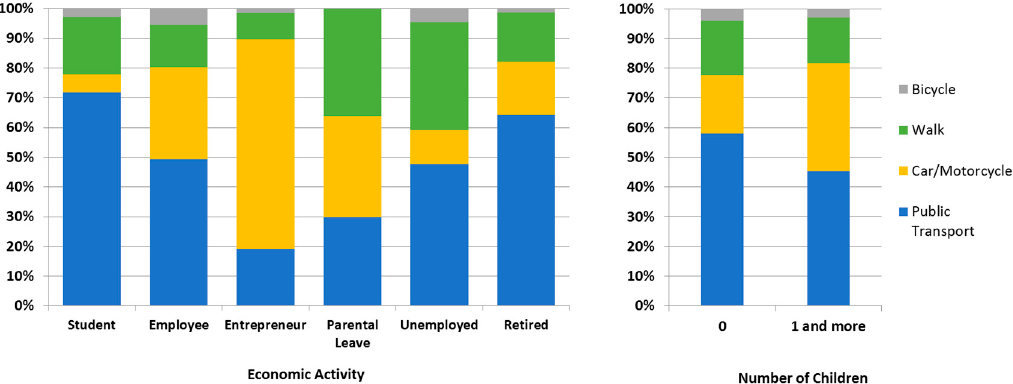
Figure 10. Portion of commuting by different means of transport according to employment status ( left ) and number of children ( right ).